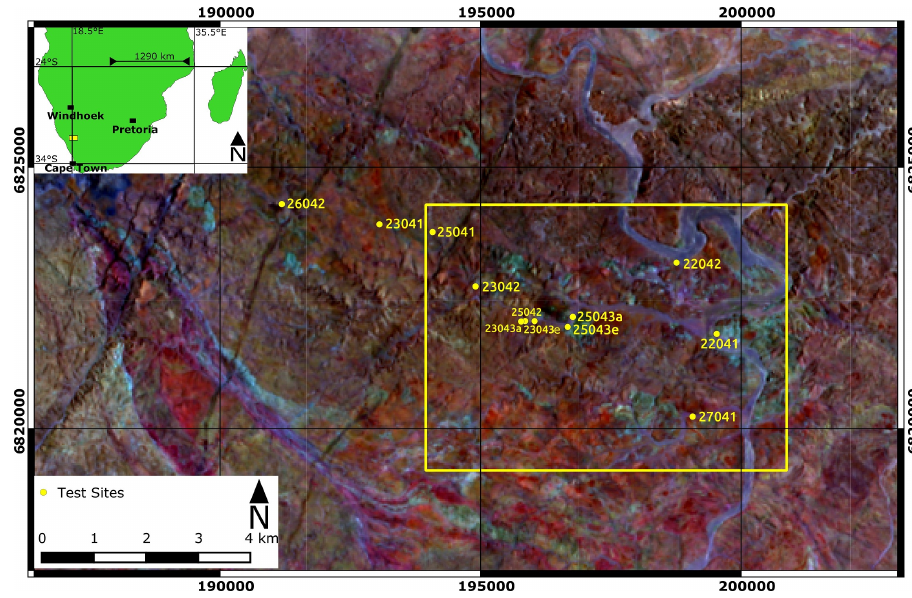
Figure 2. Simulated EnMAP composite (R: 2226 nm, G: 912 nm, B: 554 nm), of the Haib River deposit in the lower Orange River region. Zone of main mineralization outlined in yellow, field spectroscopy sites displayed as yellow circles. This band combination highlights iron oxide bearing surfaces in red, whilst areas with abundant clay minerals are highlighted in blue-green colors.